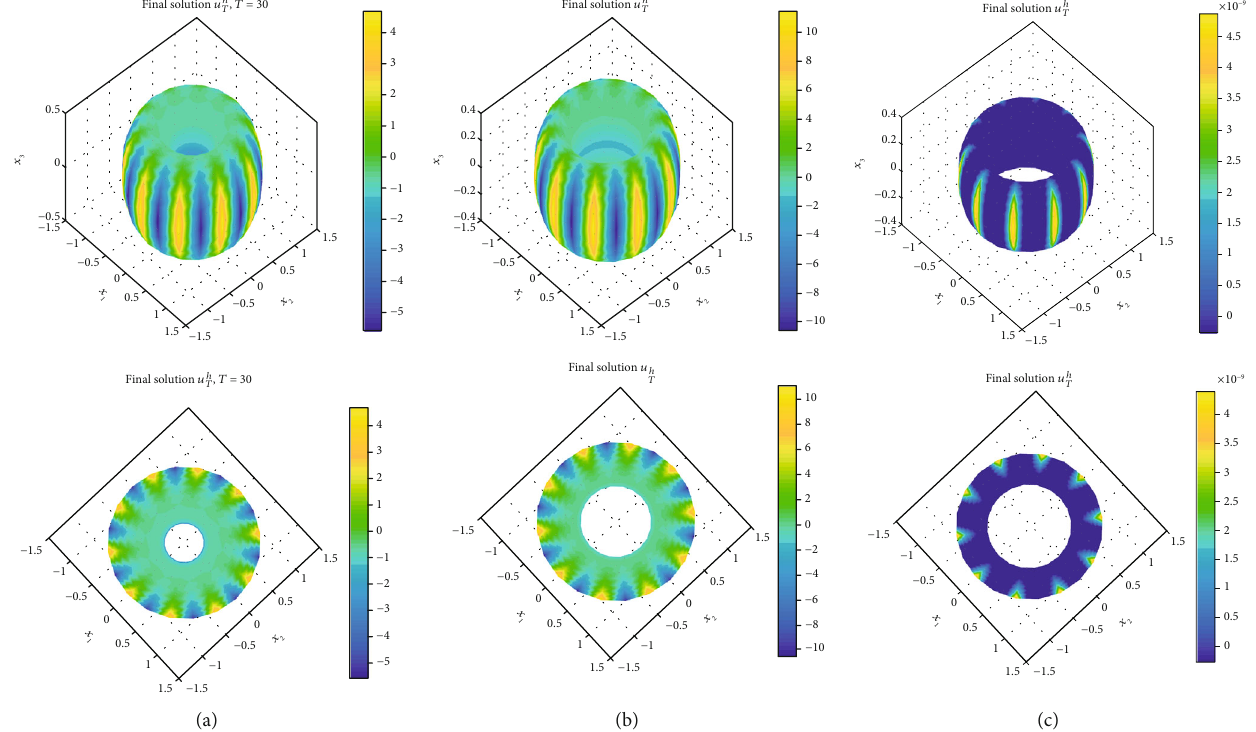
Figure 8: Final distribution u ð x , T Þ with (a) R = 0 : 75 , r = 0 : 45 , and T = 30 ; (b) R = 0 : 9 , r = 0 : 35 , and T = 100 ; (c) R = 0 : 95 , r = 0 : 25 , and T = 200 . Case: equation (22), D = 2 : 322 × 10 − 3 , D = 0 : 0045 u v